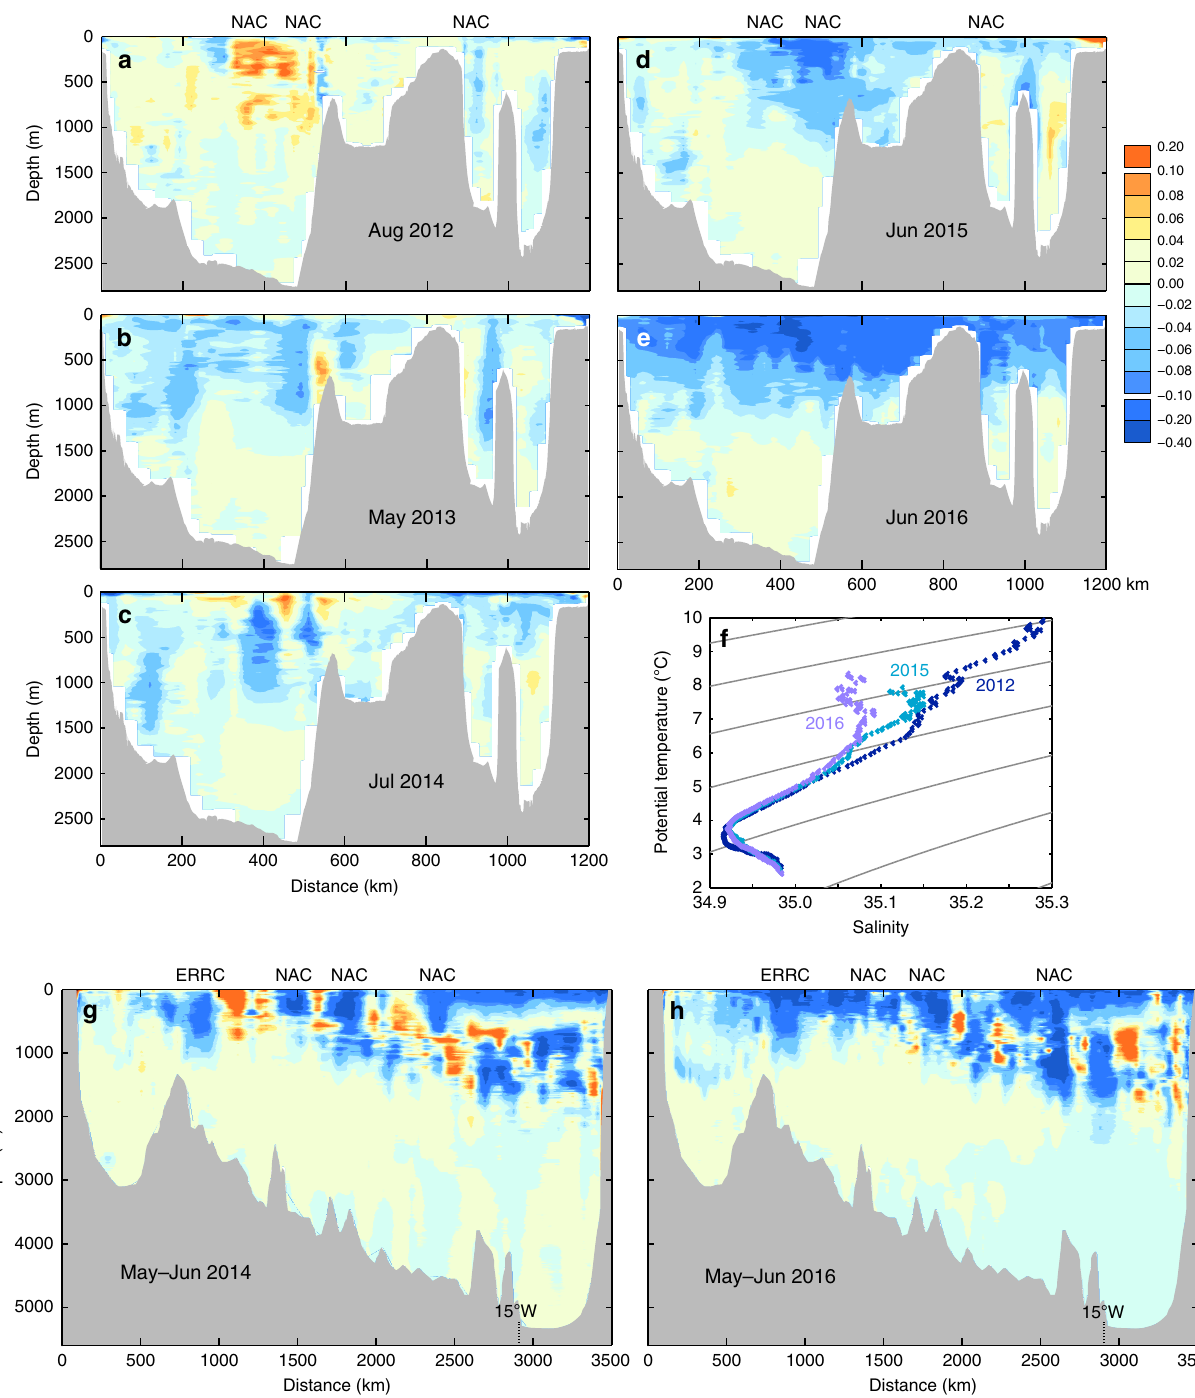
Fig. 5 Detailed spatial structure of the salinity anomalies. a – e salinity anomalies at the Extended Ellett Line (EEL) annually repeated hydrography section (mean period is 2004 – 2017); (f) Potential temperature vs. salinity for EEL sections in 2012, 2015 and 2016 in the east Iceland Basin (located at 400 – 550 km, excluding seasonally-warmed upper 50 m); g – h salinity anomalies at the OVIDE section in May – June 2014 and May – June 2016 (mean period is 2002 – 2012, colour scale is same as a – e ). Location of North Atlantic Current (NAC) and East Reykjanes Ridge Current (ERRC) branches closely tied to topography are indicated. Locations of the sections are shown in Fig.